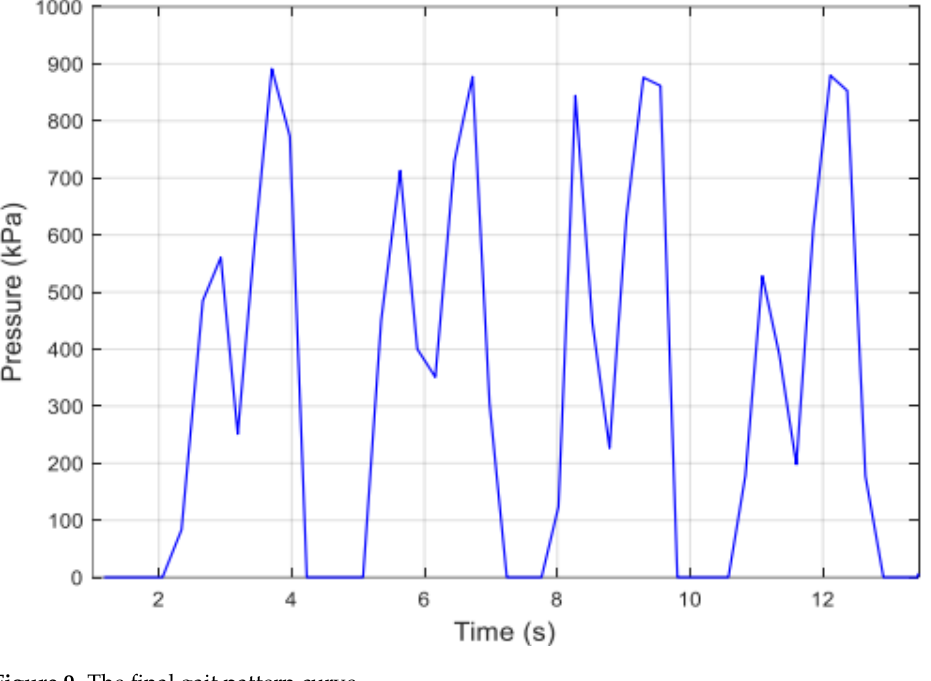
Figure 9. The final gait pattern curve.